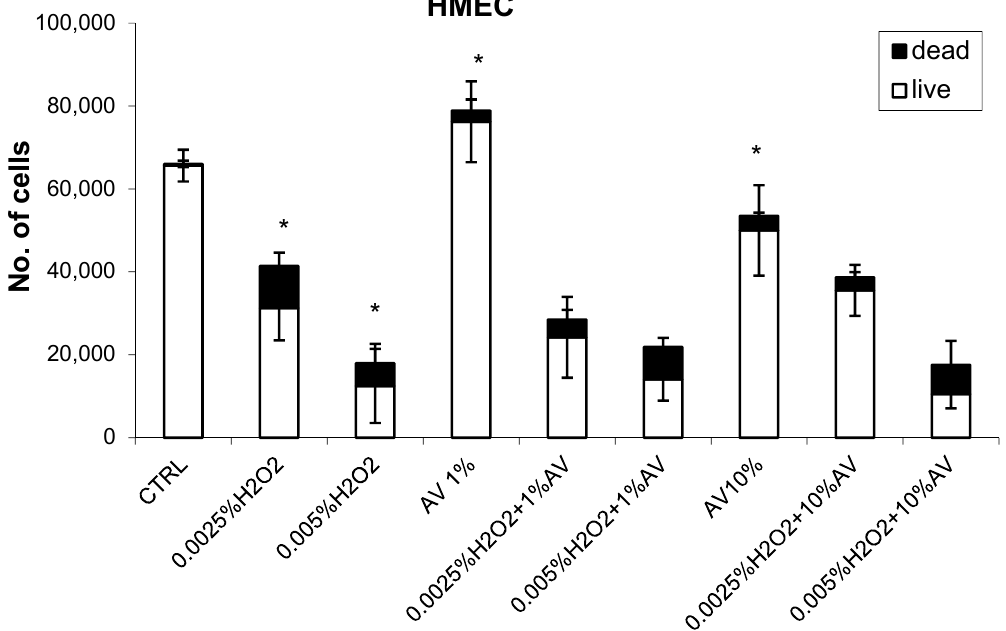
Figure 3. The effects of AV extract (1 or 10%) on the human microvascular endothelial cells (HMEC) with respect to H 2 O 2 treatment (0.0025% or 0.05%). The cell count values (viability determined using Trypan blue) were obtained 24 h after treatment (H 2 O 2 followed by AV extract 1 h later) and are given as mean values for triplicates. * significant difference to untreated control.